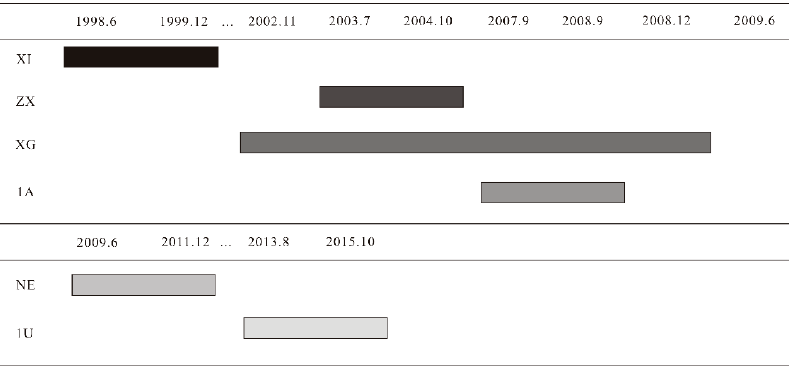
Figure 4. Distribution of teleseismic events selected by different arrays: ( a ) 1A; ( b ) 1U; ( c ) XG; ( d ) XI; ( e ) ZX; ( f ) NE.